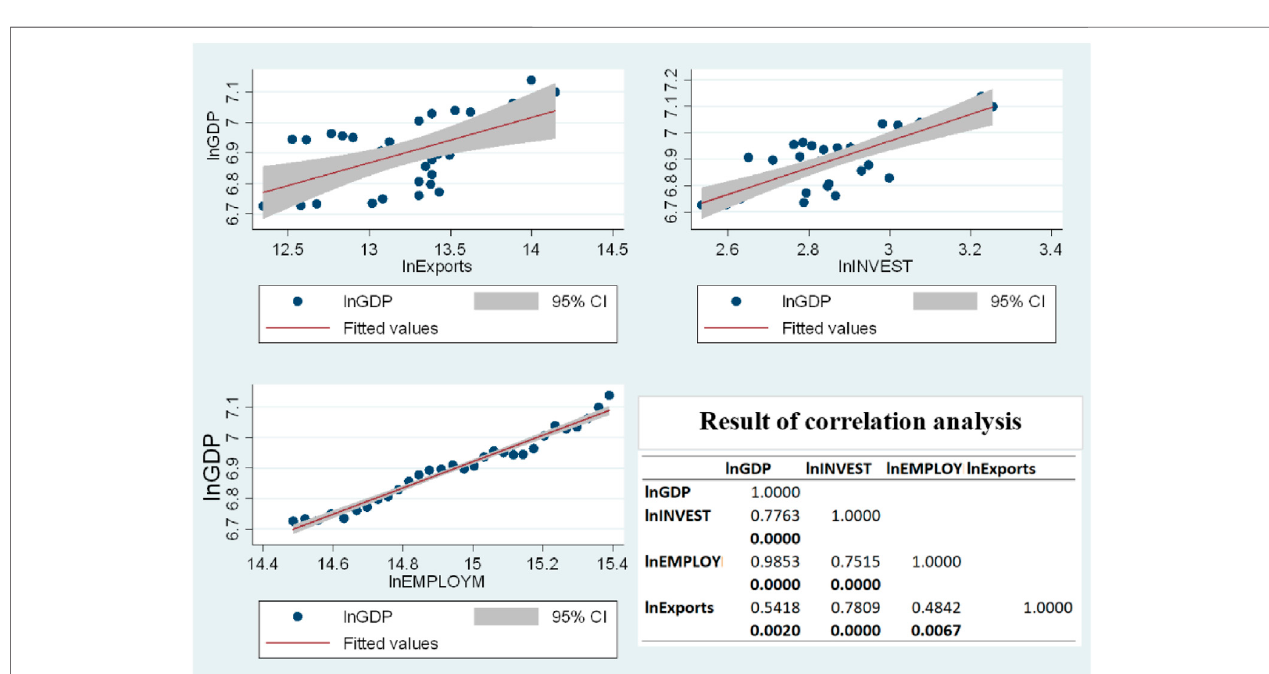
FIGURE 4 | Bivariate relationship between variables and economic growth. Source: Authors.